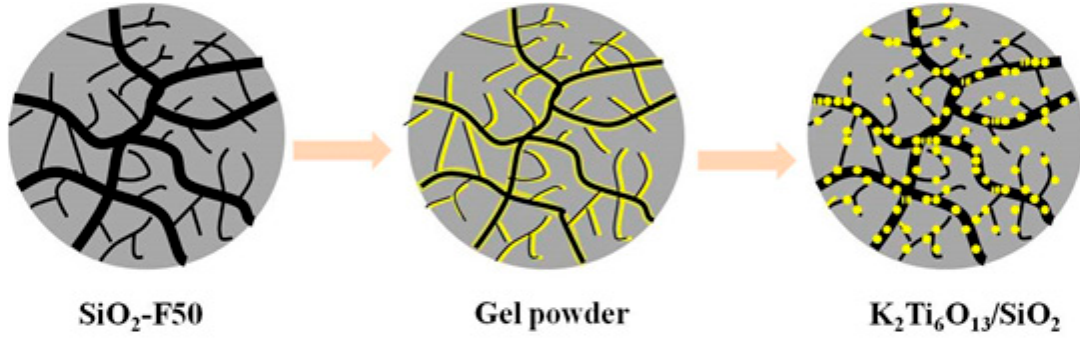
Figure 5. Process of K 2 Ti 6 O 13 /SiO 2 preparation [48].